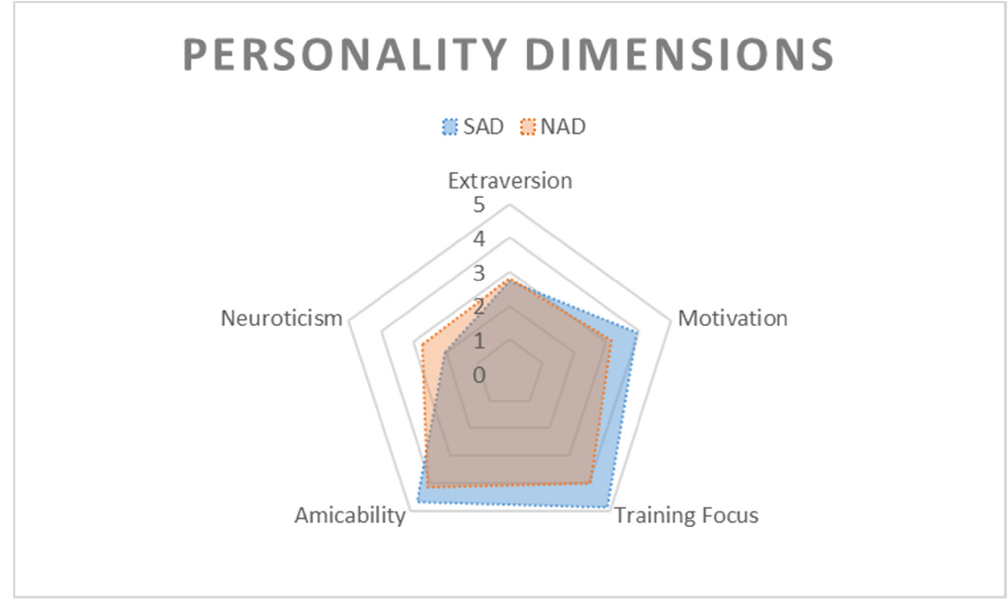
Figure 3. Personality dimensions: Representation of seizure-alert dogs (SAD) and non-alerting dogs (NAD) on the five dimensions of the Monash Canine Personality Questionnaire-Revised (MCPQ-R).